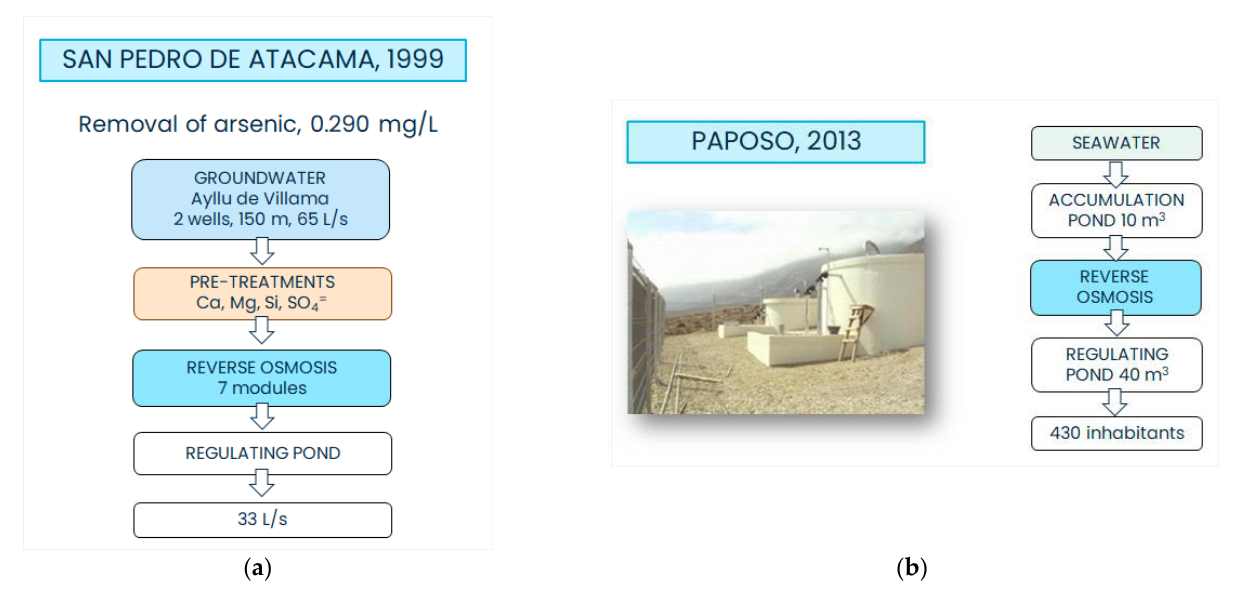
Figure 3. Scheme of the treatment train for the APR WTP of ( a ) San Pedro de Atacama and ( b ) Caleta Paposo, Taltal.